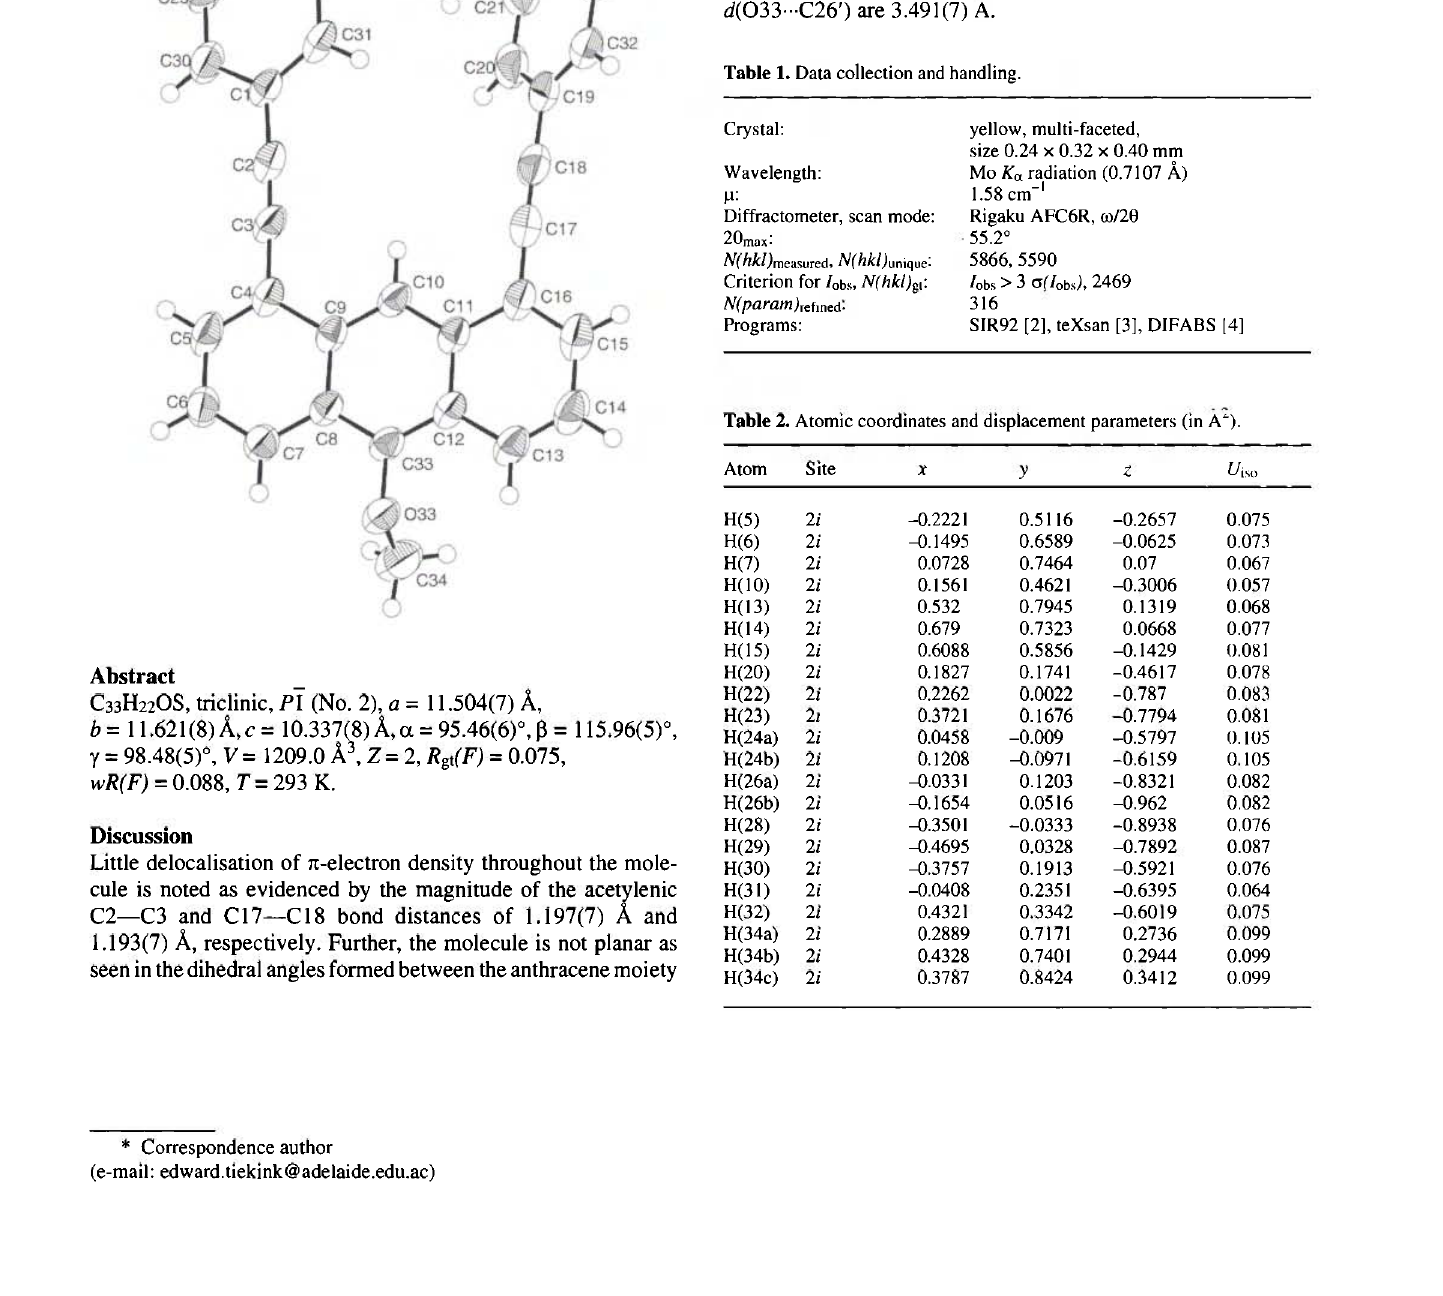
Table 1. Data collection and handling.